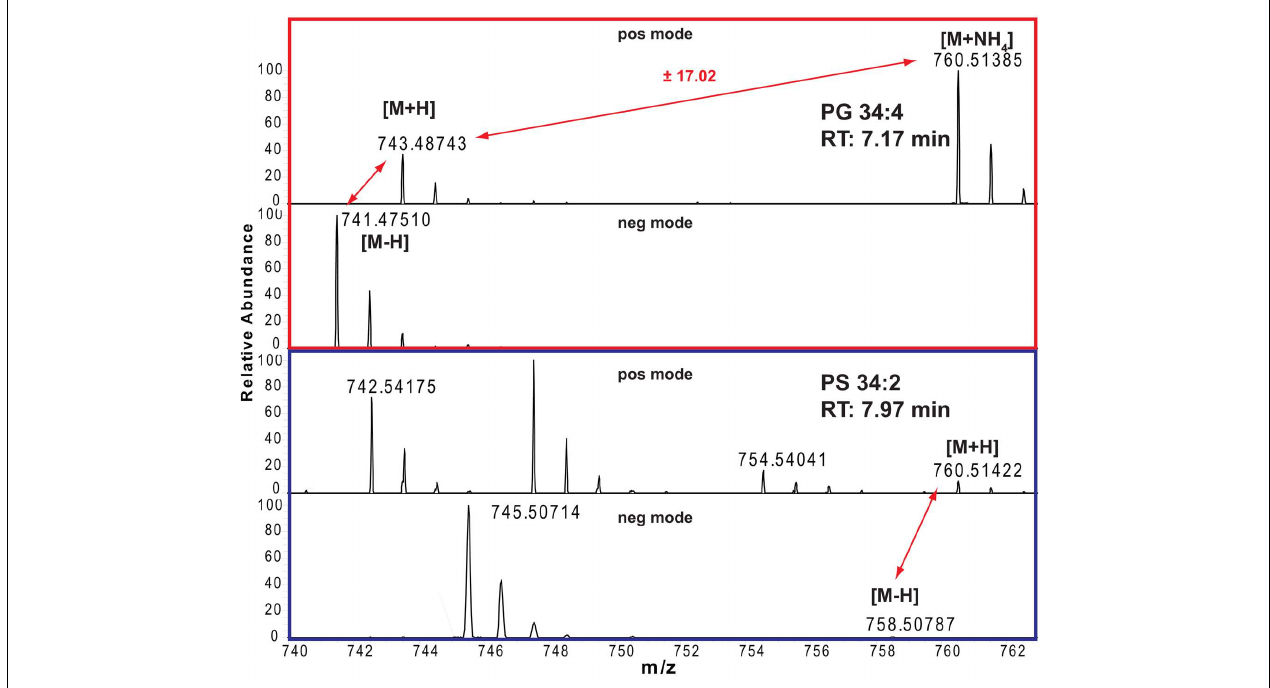
FIGURE 2 | Positive and negative ion mode spectra and adduct annotations of PG 34:4 (red boxed) and PS 34:2 (blue boxed).